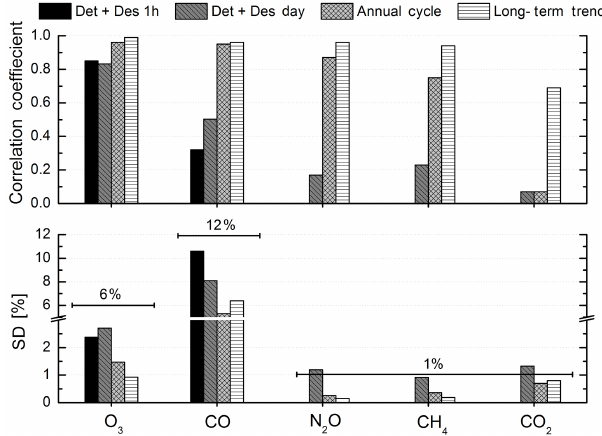
Figure 7. Pearson correlation coefficient (upper panel) be- tween IASI-A and FTS observations for all the trace gases considered at different timescales: single measurements (de- trended + de-seasonalised variability within ± 1h, Det + Des 1h), daily (de-trended + de-seasonalised variability within the same day, Det + Des Day), annual, and long-term trend. The number of coin- cident data is 2338 for O 3 , 2003 for CO, and 425 for N 2 O, CH 4 , and CO 2 . Bottom panel shows the same, but for the standard deviation (in %) of the corresponding differences. The solid black lines repre- sent the day-to-day variability calculated from the FTS observations at IZO between 2010 and